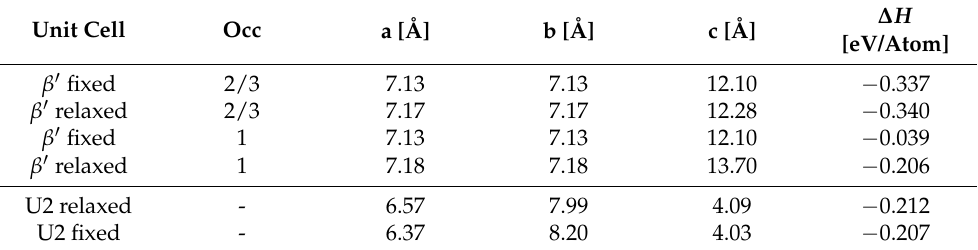
Figure 4. (Color online). The relaxed unit cell of U2 as established by Frøset et al. [16]. Table 1. Unit cell parameters and formation enthalpy of bulk β (cid:48) models as given in Equation (2), with full and 2/3 occupancy of the 00 z Si sites. “Fixed” unit cell means that the cell parameters were compressed to match the Al matrix and only the atomic positions were allowed to